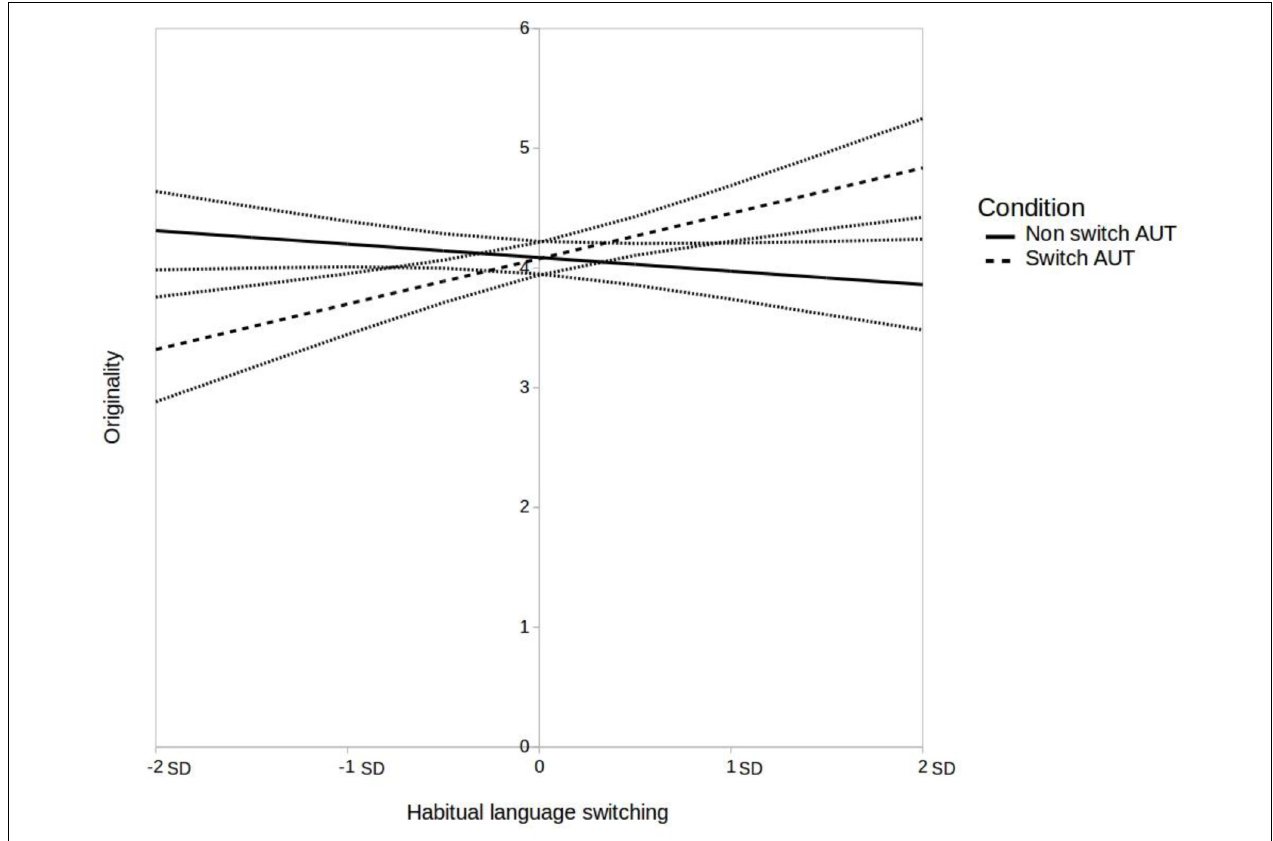
FIGURE 2 | Interaction of language switching condition and habitual language switching on originality scores, controlling for fluency scores (Model B). 95% confidence intervals are represented by gray lines.